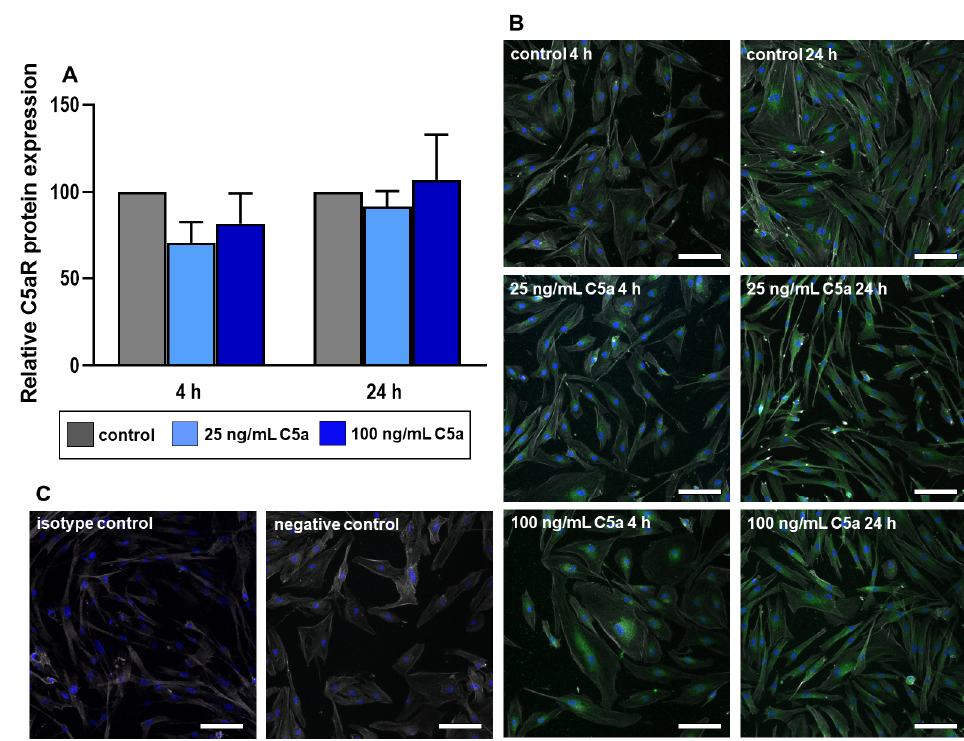
Figure 6. Tenocyte protein expression of C5aR after 4 and 24 h stimulation with 25 ng/mL (light blue) and 100 ng/mL (dark blue) recombinant C5a protein in comparison to the control group (grey) ( A ). Fluorescence intensity indicating C5aR immunoreactivity was analyzed using ImageJ. Mean values and the standard errors of mean are shown. Controls have been normalized to 1. Rout outlier test Q = 1.0%. Shapiro Wilk normality test was used to test the normal distribution of data. One sample t -test was performed in relation to control. ( B ) Representative images of tenocytes immunolabeled with C5aR specific antibodies. Green (Alexa 488) = C5aR, blue (DAPI) = cell nuclei, grey (Phalloidin Alexa 633) = actin cytoskeleton. Scale bar = 100 µ m. ( C ) Isotype & negative controls of the immunofluorescence staining. n = 4 independent experiments with human tenocytes from different donors were